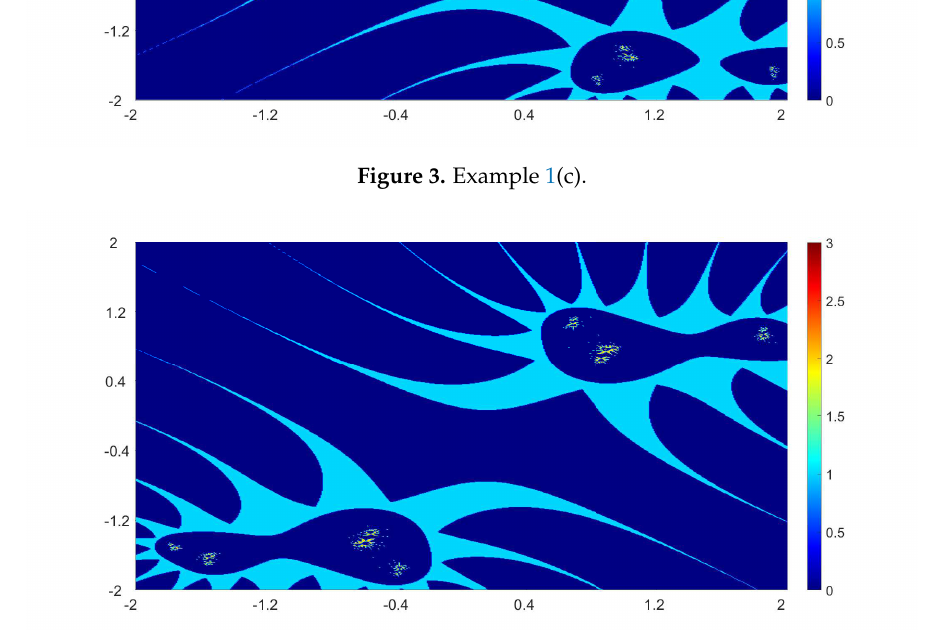
Figure 3. Example 1(c).